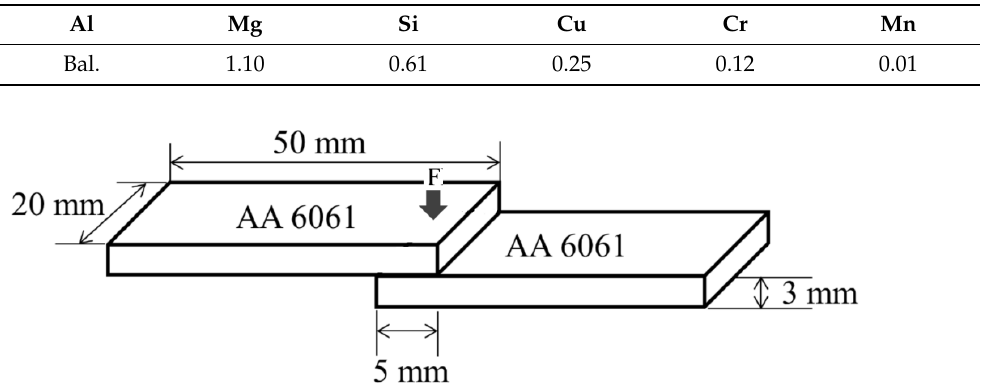
Table 1. Chemical composition of AA 6061 aluminum alloy (wt.%).